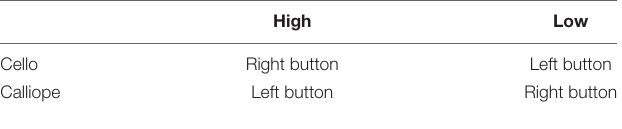
Figure 1 . The S-R stimulus features (timbre: “cello”/“calliope” and pitch: “high”/“low”) comprising the set of (S-R) mapping table ( Table 1 ) specifies the conjunction contingencies